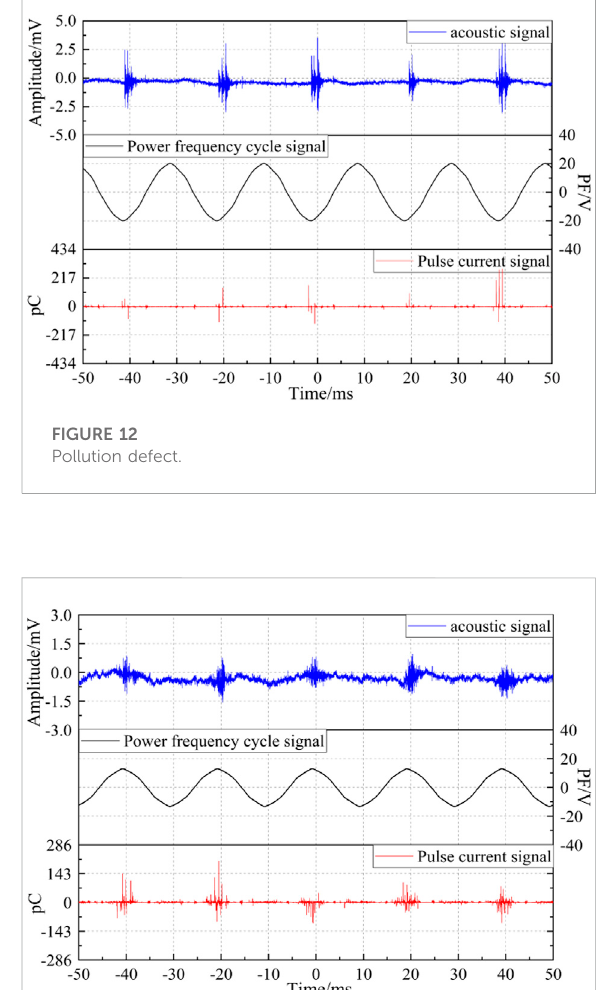
FIGURE 13 Metal foreign matter defect.